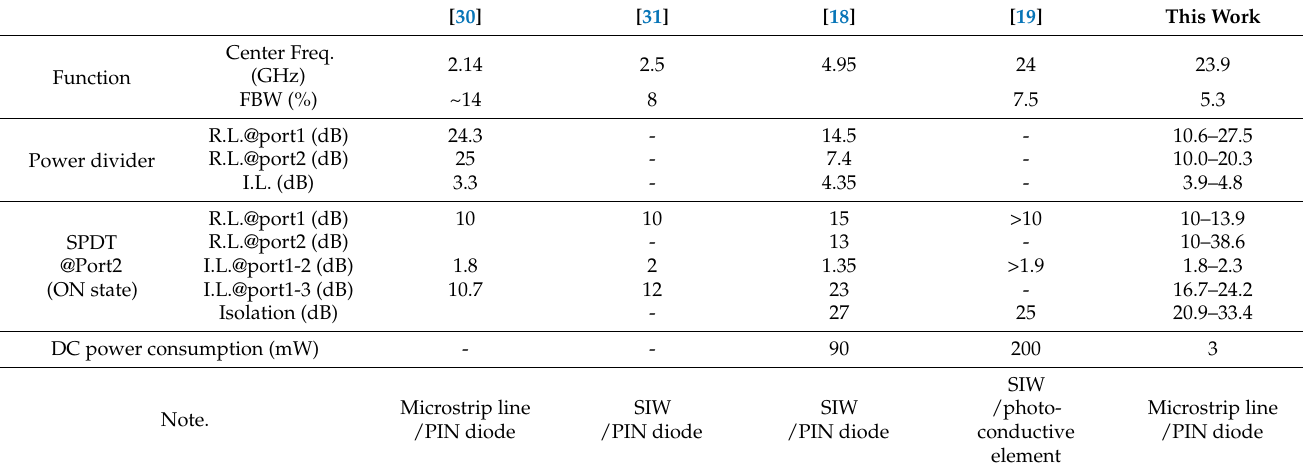
Table 1. Performance comparison of the proposed RF switch with published RF switches.